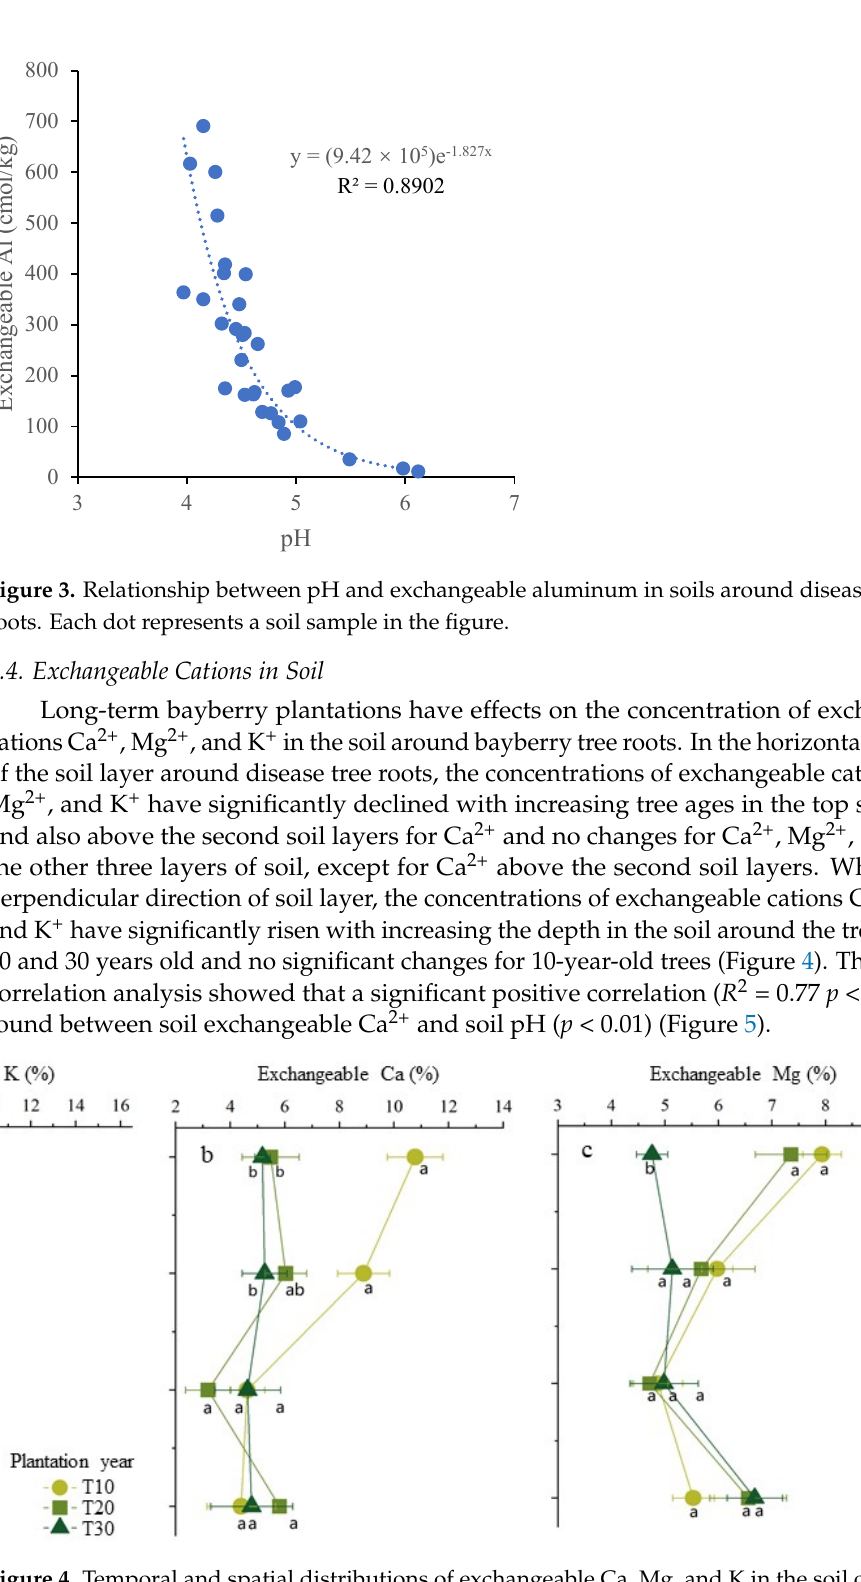
Figure 4. Temporal and spatial distributions of exchangeable Ca, Mg, and K in the soil of bayberry orchards. The contents of exchangeable Cations (abscissa axis) in different soil depth (axis of ordi- nates) from sample soil of the different tree ages of T10 for 10 years old, T20 for 20 years old, and T30 for 30 years old were showed for exchangeable K in ( a ), for exchangeable Ca in ( b ), and for exchangeable Mg in ( c ). Different letters between different bayberry tree ages represent significant differences ( p < 0.05).